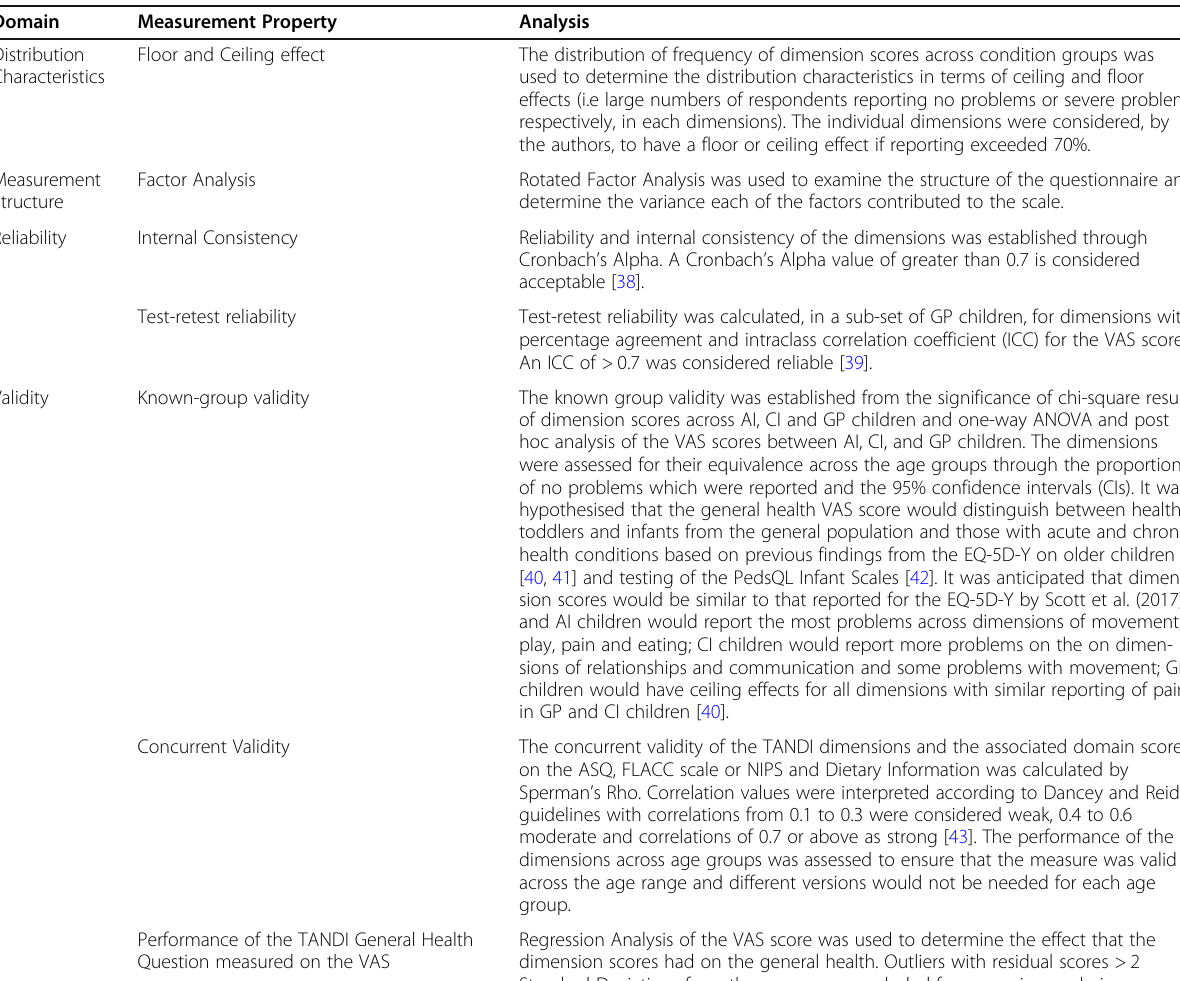
Table 1 Measurement Properties